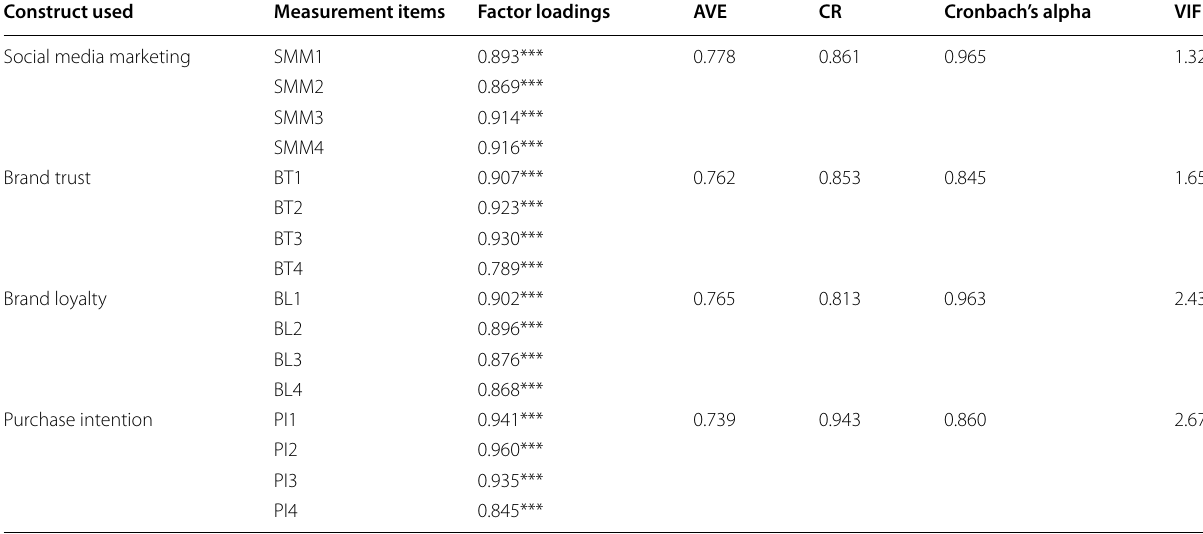
Significant at ***p < 0.01